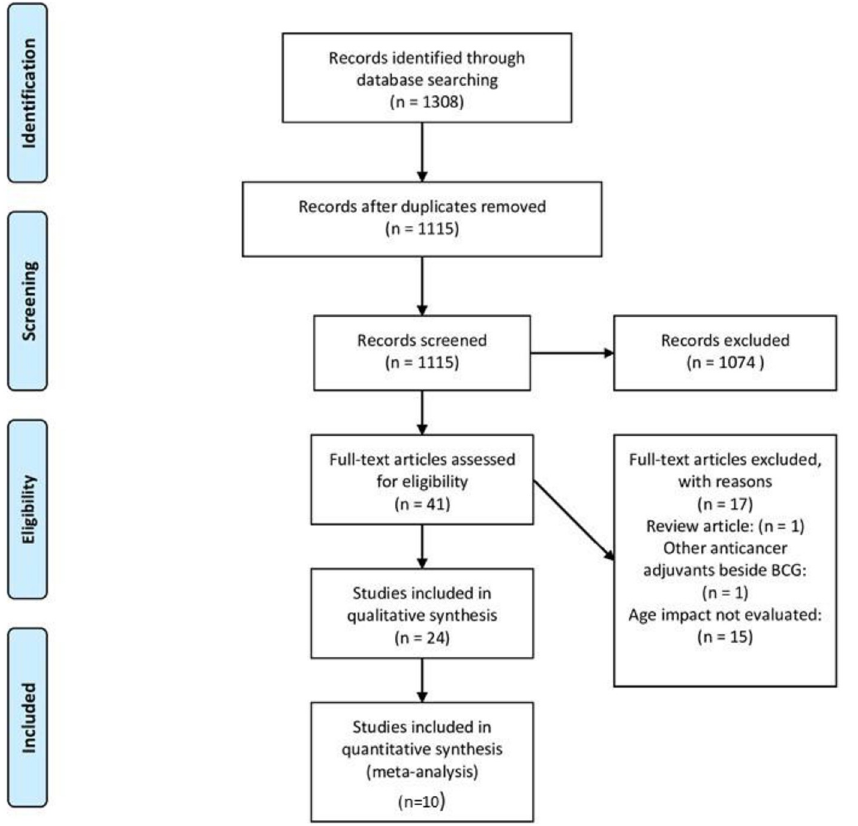
Fig 1. Flow diagram of study selection for the current